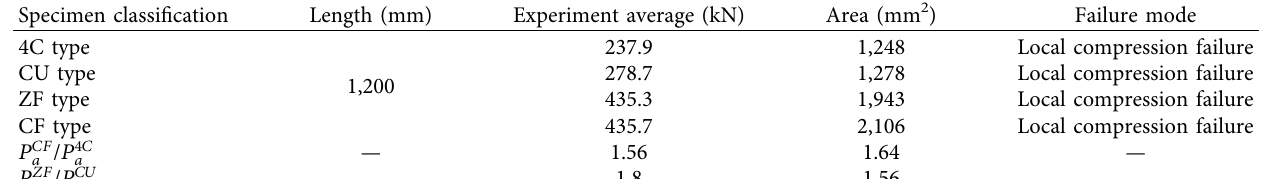
Table 3: Comparison of test values between built-up section and profiled steel section. Specimen